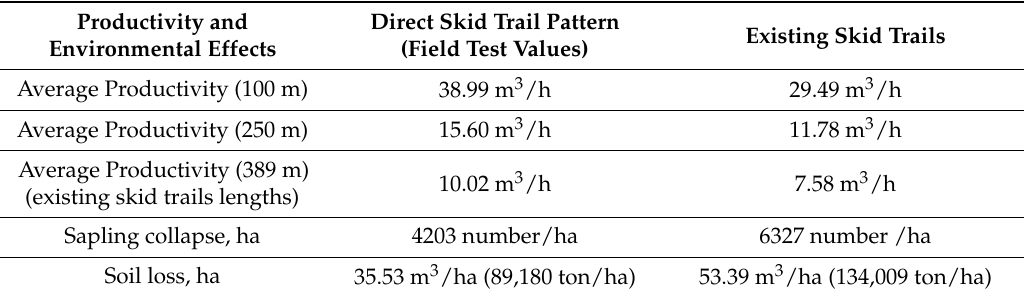
Table 4. Comparison of the productivity and environmental